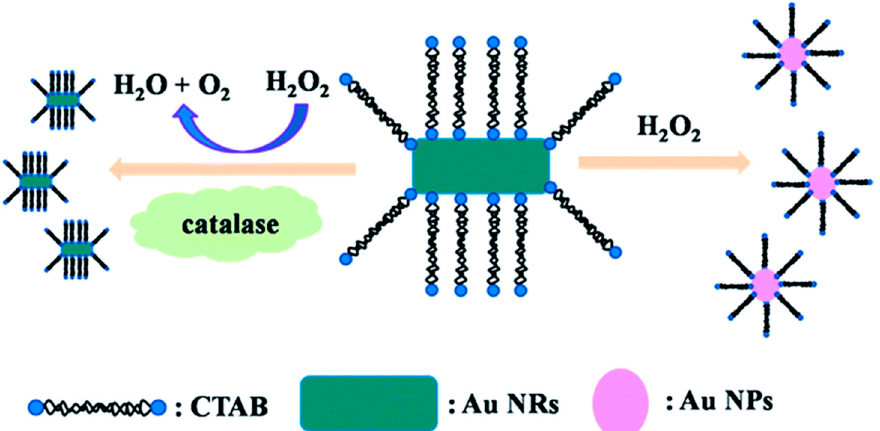
Figure 9. The schematic illustration for colorimetric detection of catalase based on the decomposition of H 2 O 2 , which inhibits H 2 O 2 etching of AuNRs. Reproduced with permission from Reference [97]. Royal Society of Chemistry, 2016.